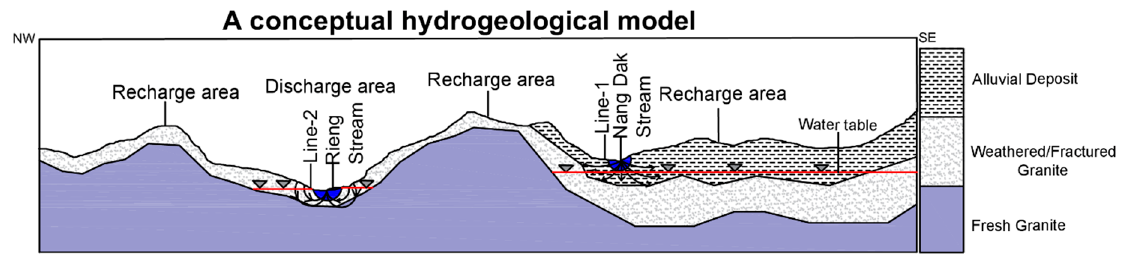
Figure 12. A simplified conceptual hydrogeological model of the study area.